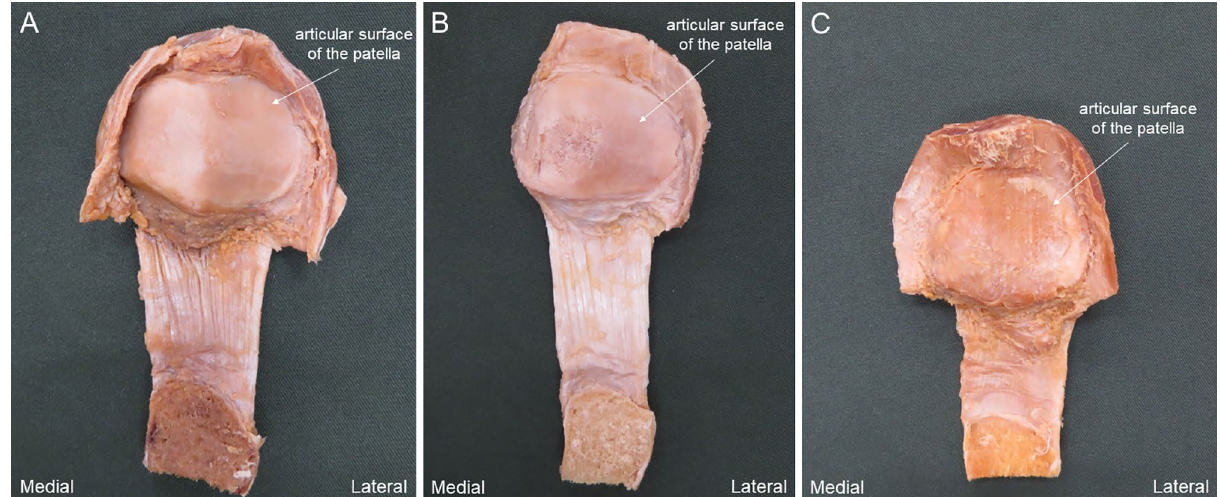
Figure 6. Classification of degenerative grade of the articular surface. ( A ) Grade I: macroscopically intact or only mildly altered. ( B ) Grade II: macroscopically moderately altered (if fissuring or fibrillation is observed). ( C ) Grade III: macroscopically severely altered (if eburnation is